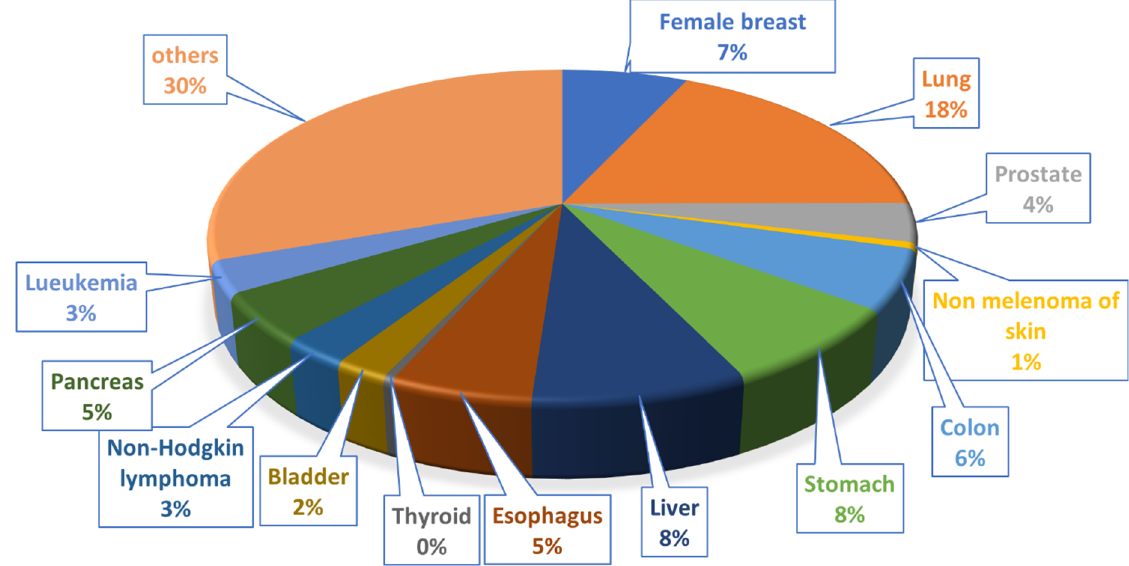
Figure 1. Global distribution of the top 13 cancer types with the highest mortality rate.